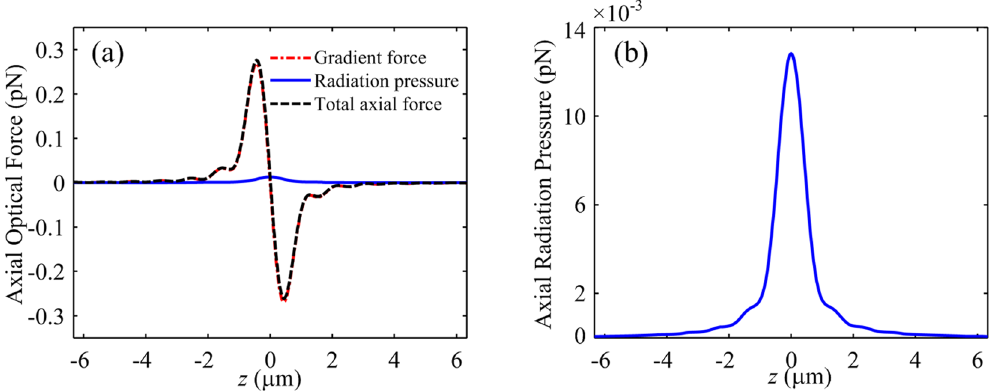
Figure 6. Axial optical forces on a 30 nm (radius) dielectric particle with n 2 = 1.6 located on the optical axis z . ( a ) Total axial optical force. ( b ) Axial radiation